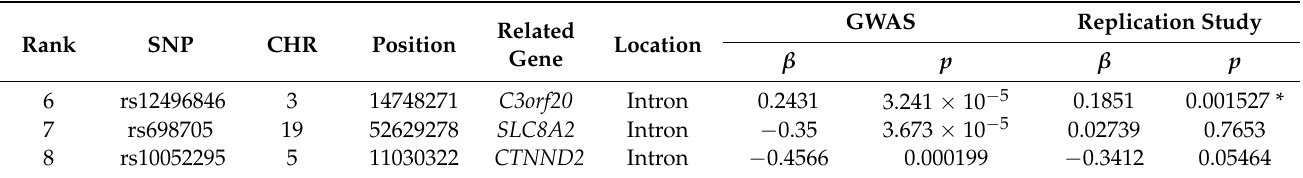
Table 2. Results of replication STUDY for three potent candidate SNPs that were selected in the GWAS (additive